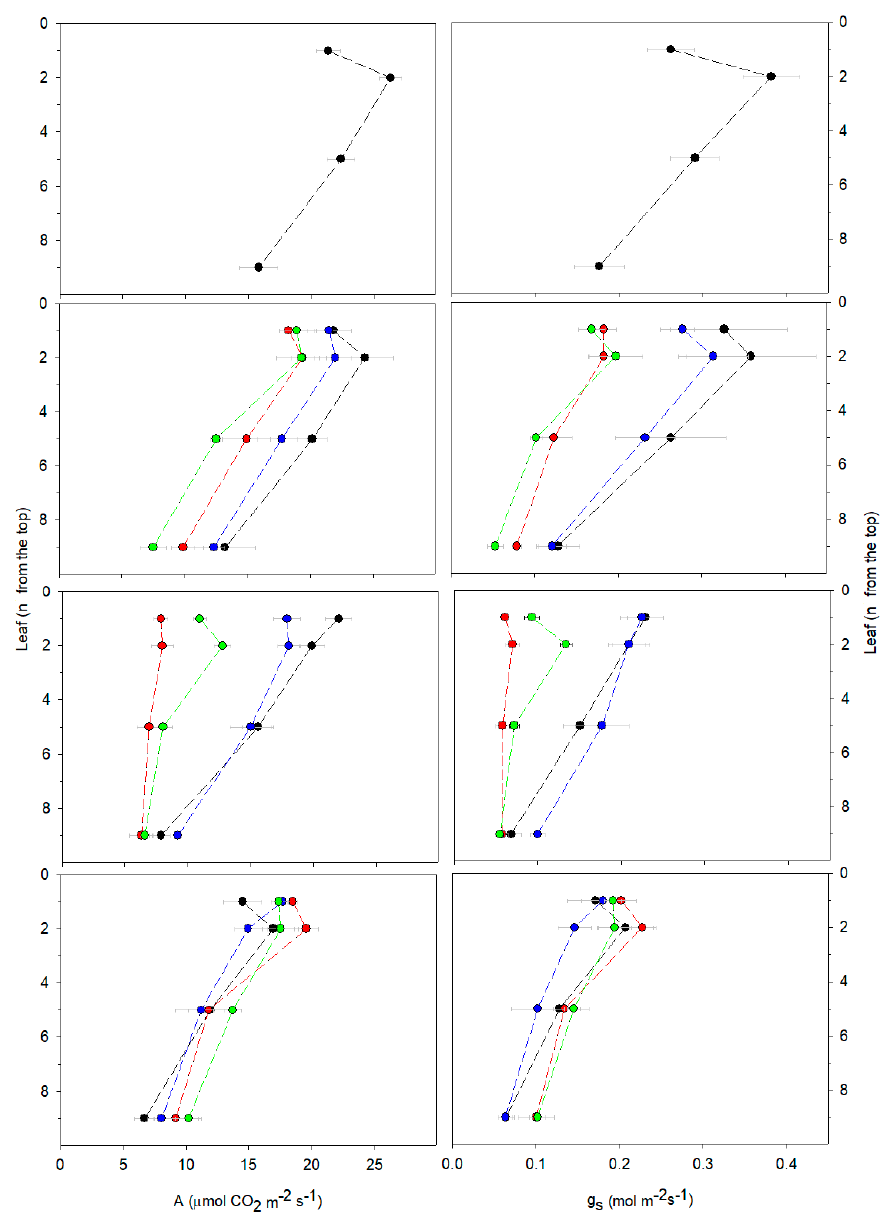
Figure 2. Photosynthetic CO 2 assimilation rate ( A ) and stomatal conductance (gs), measured at different time points (T0, T1, T2, and R) in the 1st and 2nd (apical), 5th (median), and 9th (basal) leaves counted from the top of Arundo donax controls (black circles), salt-stressed (red circles), ALA- treated (blue circles), and both salt-stressed and ALA-treated (green circles) plants. Dotted lines connect leaves belonging to the same plant profile. Mean values ± SE are shown. Statistically significant difference between (apical, median, and basal) leaves of plants undergoing the same treatment and between (apical, median, and basal) leaves of plants undergoing different treatments are shown in Table